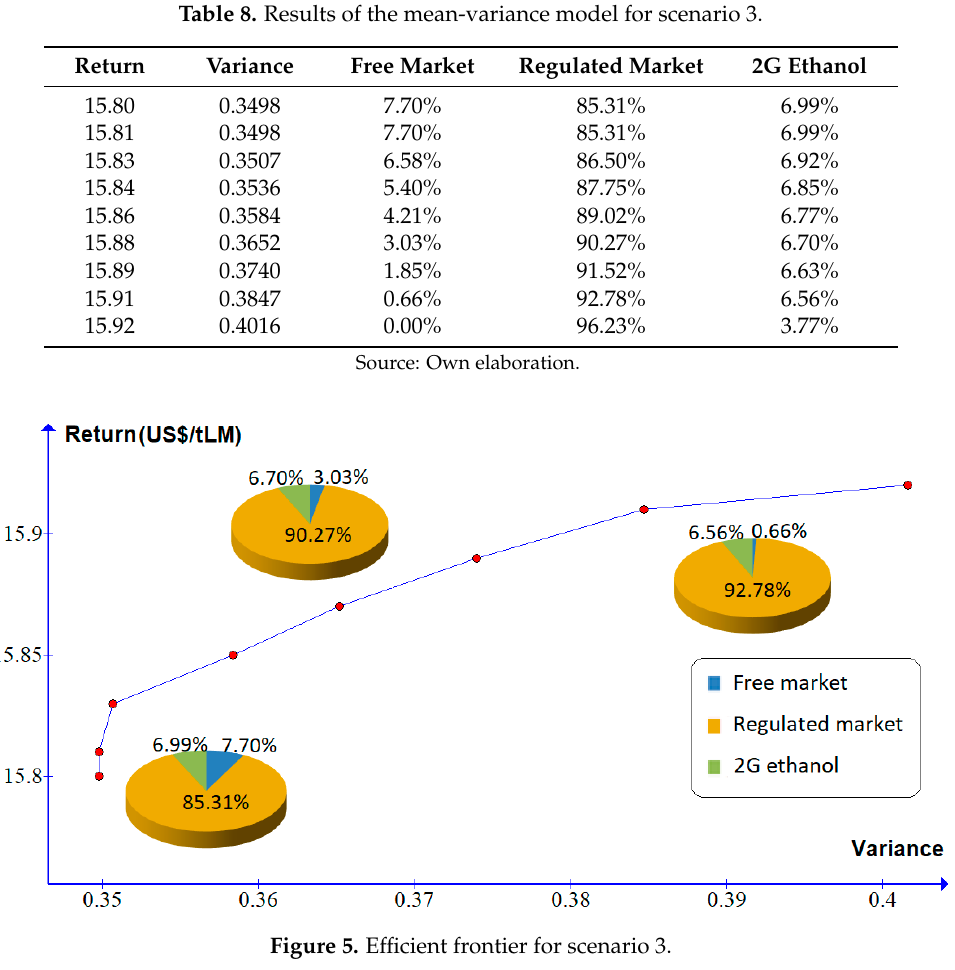
Table 8. Results of the mean-variance model for scenario 3.